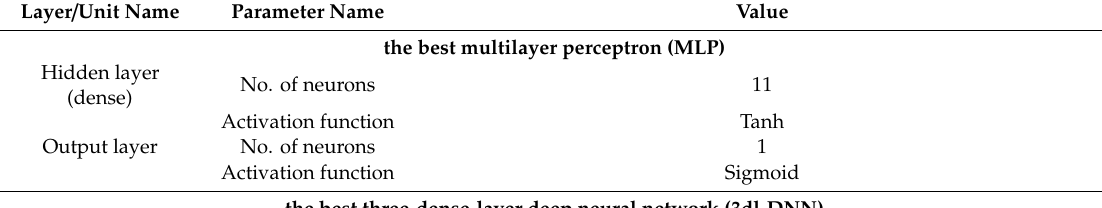
Table 5. Structure parameters of the best artificial neural networks